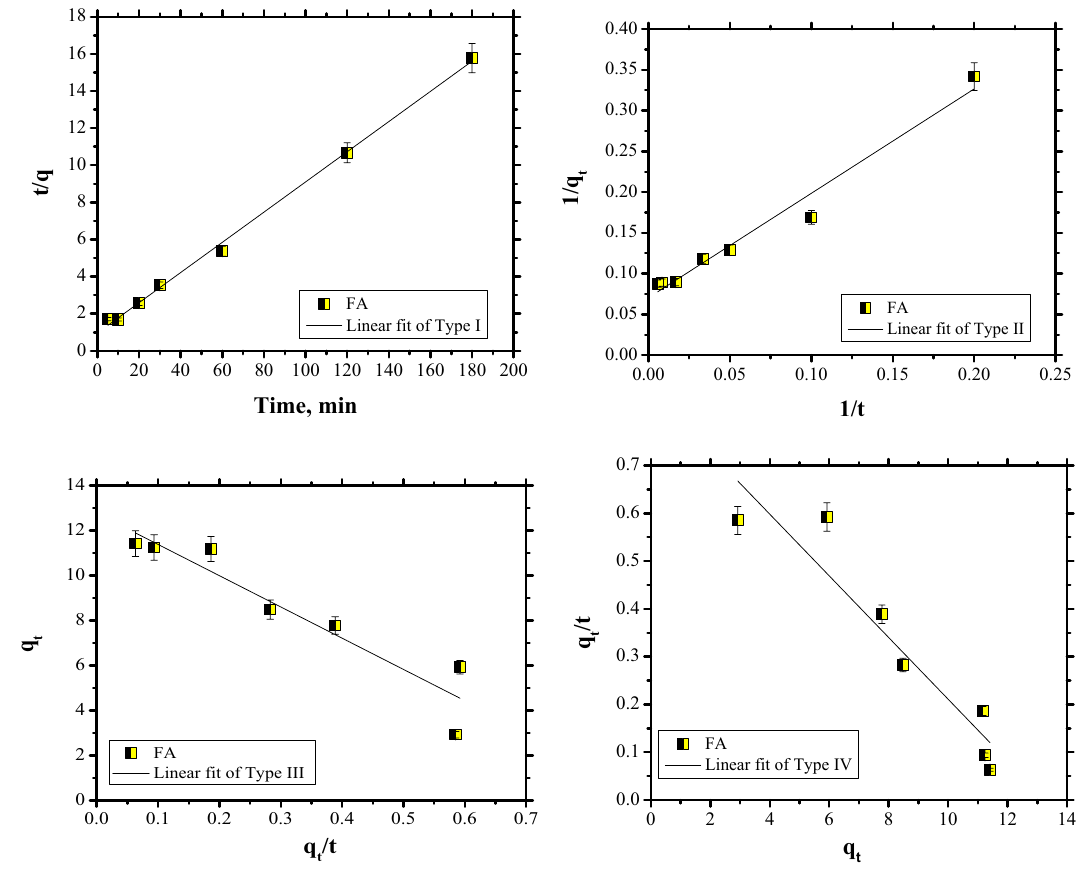
Figure 14. Pseudo-second-order model, Types I–IV.